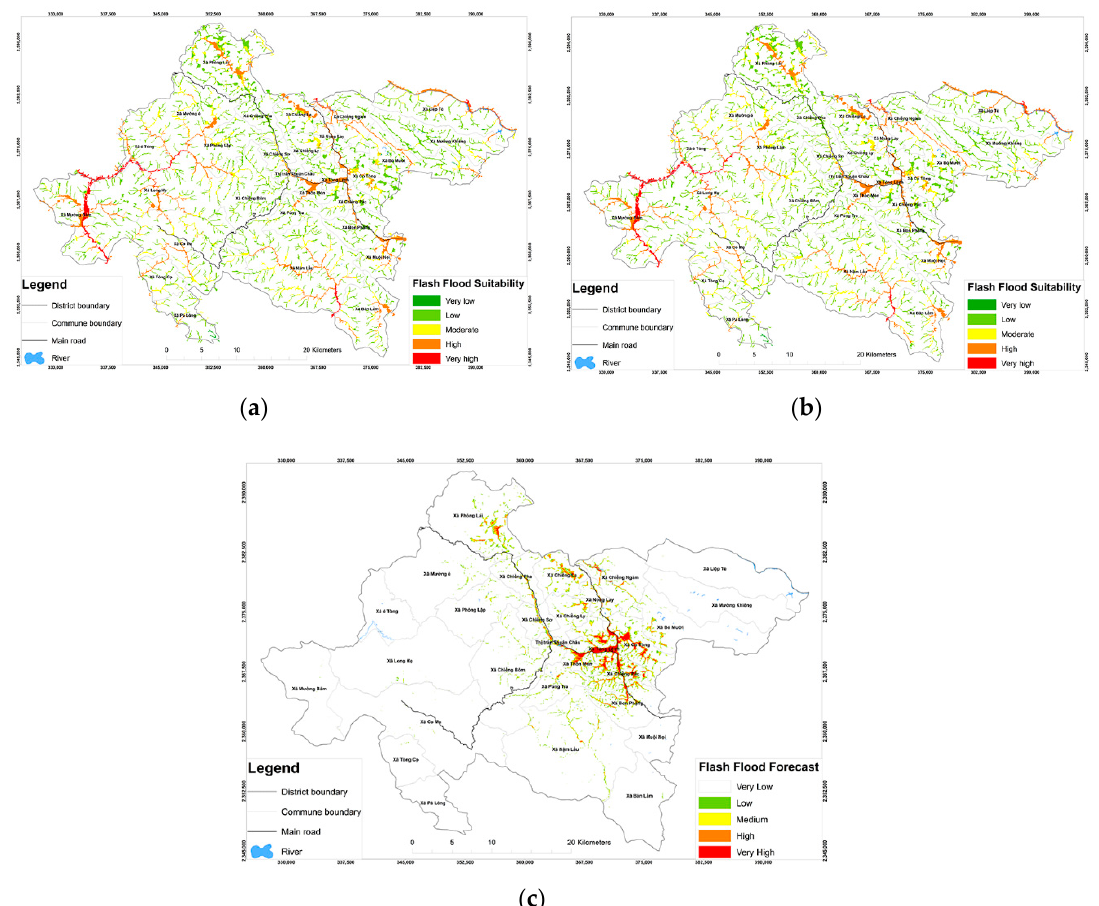
Figure 7. Results of flash-flood forecast processing by rainfall in Thuan Chau district: ( a ) Forecast rainfall map, ( b ) flash-flood risk map and ( c ) early flash-flood forecast map by the forecast rainfall, with a flash flood generation threshold of 150 mm/d [13].